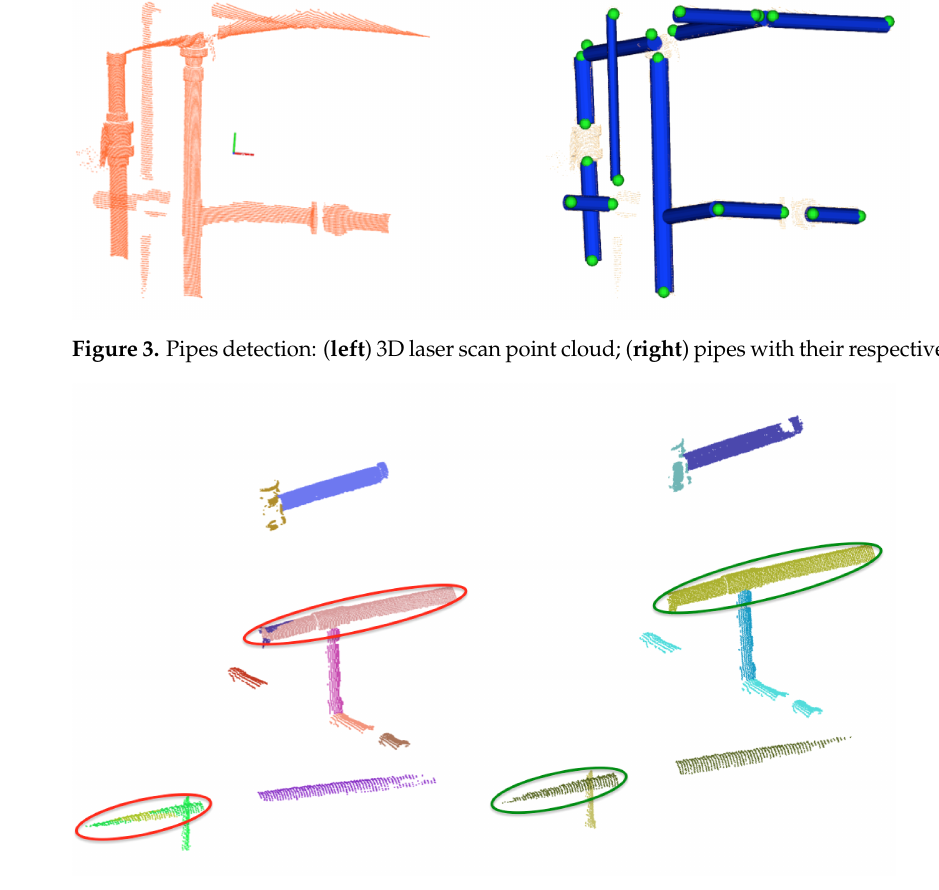
Figure 4. Pipes Merging: ( left ) Pipe detection result previous to merging showing, within circles, multiple pipe detections of the same pipe; ( right ) Result after merging where the multiple detections have been merged into a single